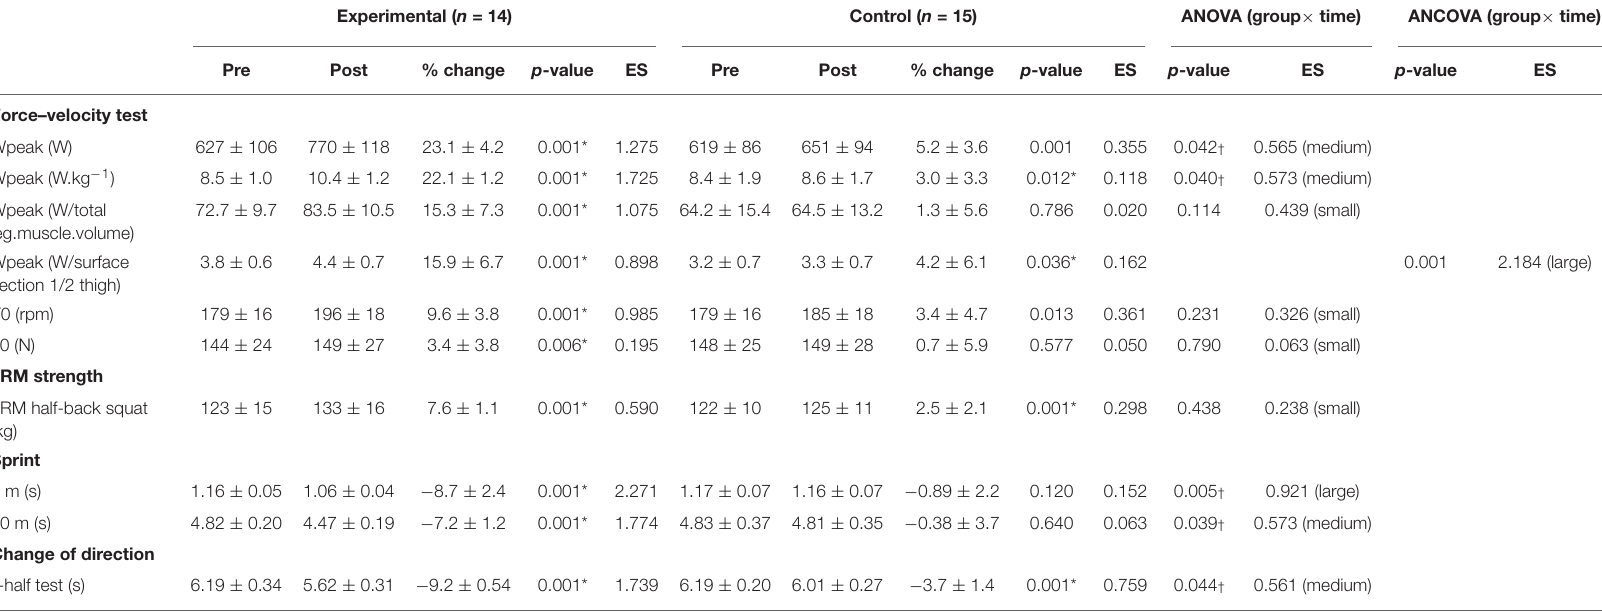
TABLE 5 | Force-velocity test data, 1RM strength, sprint times, and change of direction performance for experimental and control groups before and after the 8 weeks intervention. Experimental ( n = 14) Control ( n = 15) ANOVA (group × time) ANCOVA (group × time)